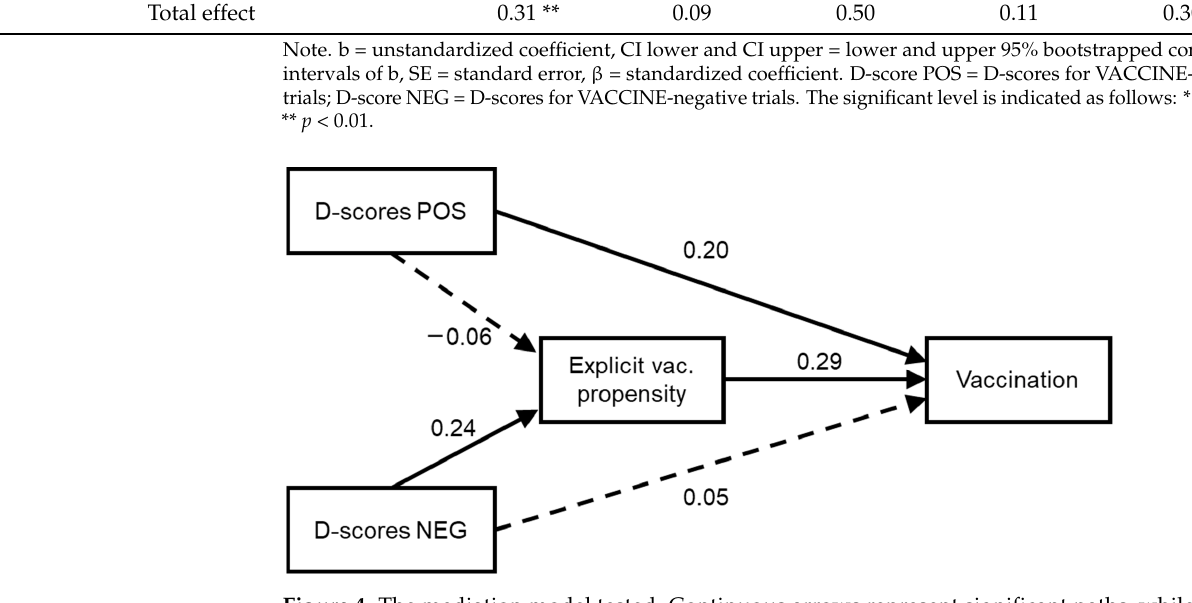
Figure 4. The mediation model tested. Continuous arrows represent significant paths, while dotted arrows represent non-significant paths. Indirect effects are reported in the text. The effects of covari- ates (sex, age, and education level) are not reported for the sake of clarity. D-score POS = D-scores for VACCINE-positive trials; D-score NEG = D-scores for VACCINE-negative trials.